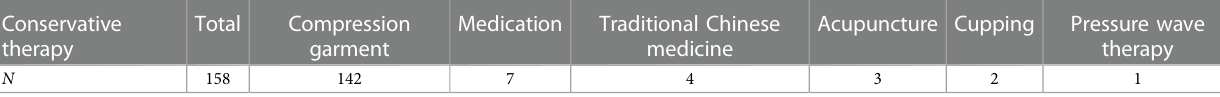
TABLE 1 Conservative therapies before visit to the